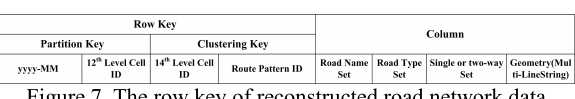
Figure 7. The row key of reconstructed road network data